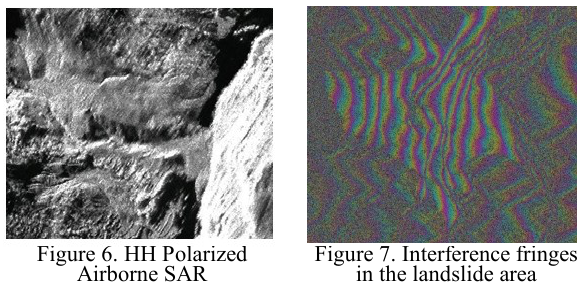
Figure 6. HH Polarized Airborne SAR